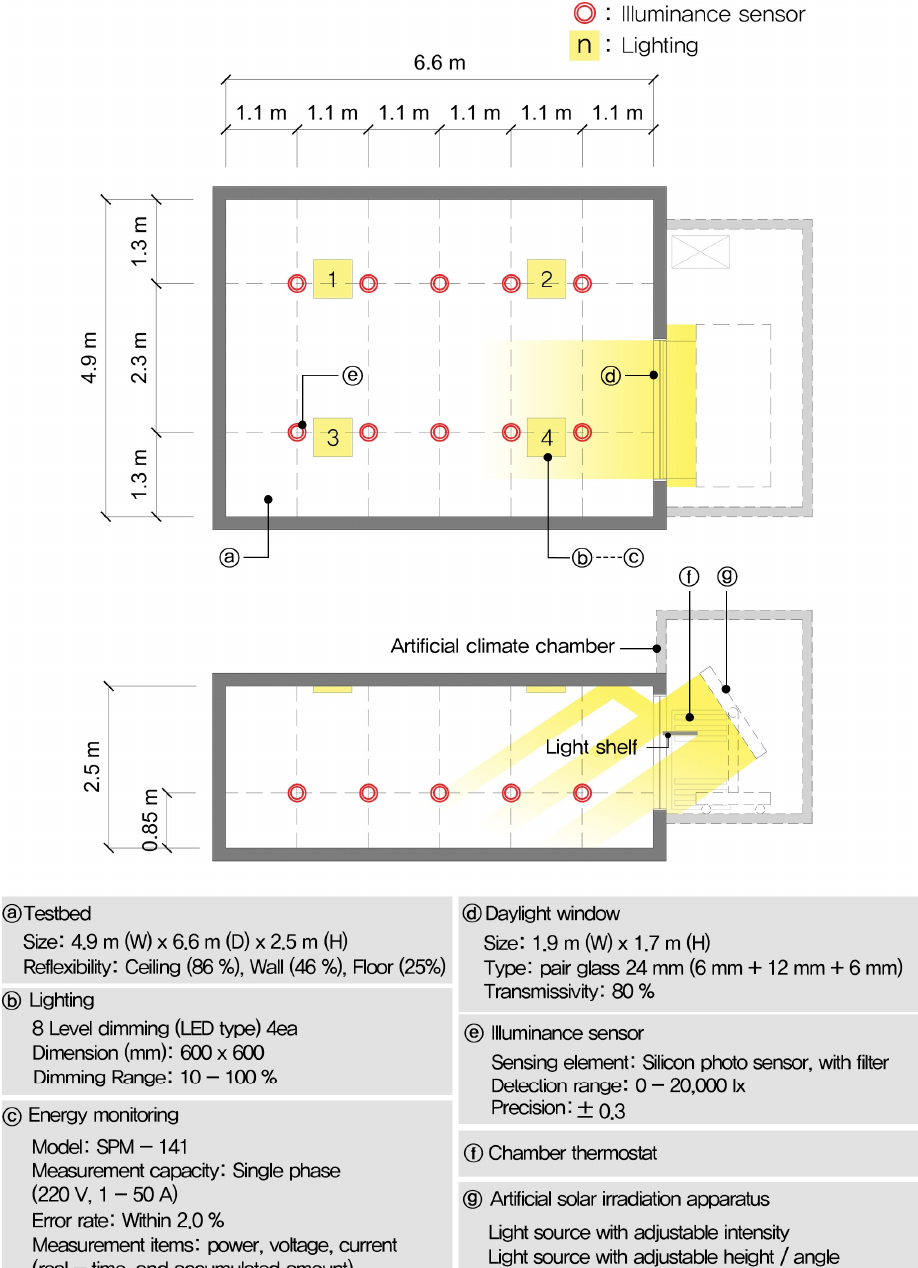
Figure 4. The layout, cross-section, and equipment in the testbed for performance evaluation.